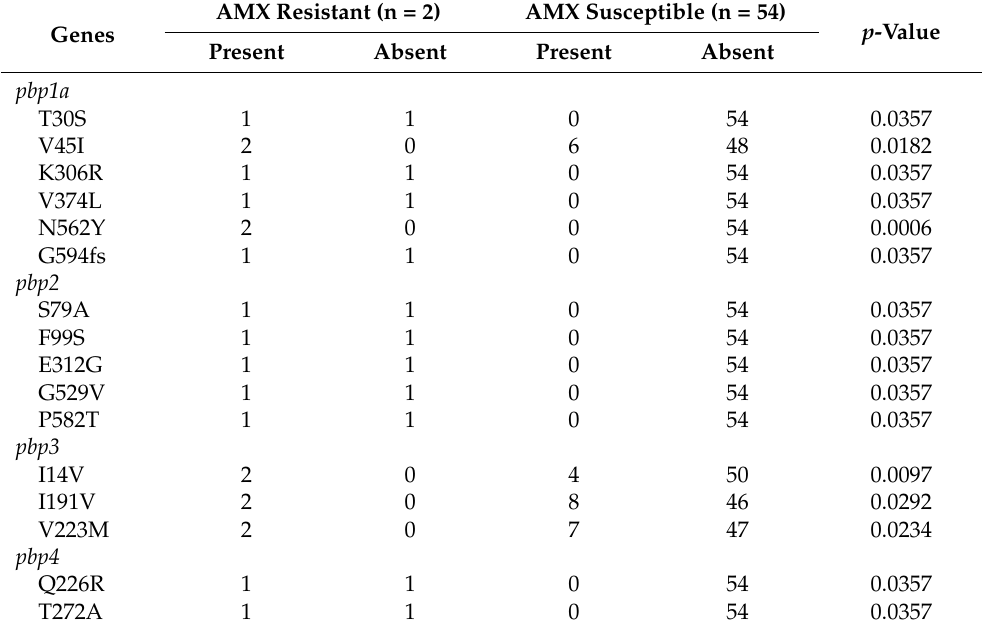
Table 2. Significant mutations found in Amoxicillin resistance in H. pylori